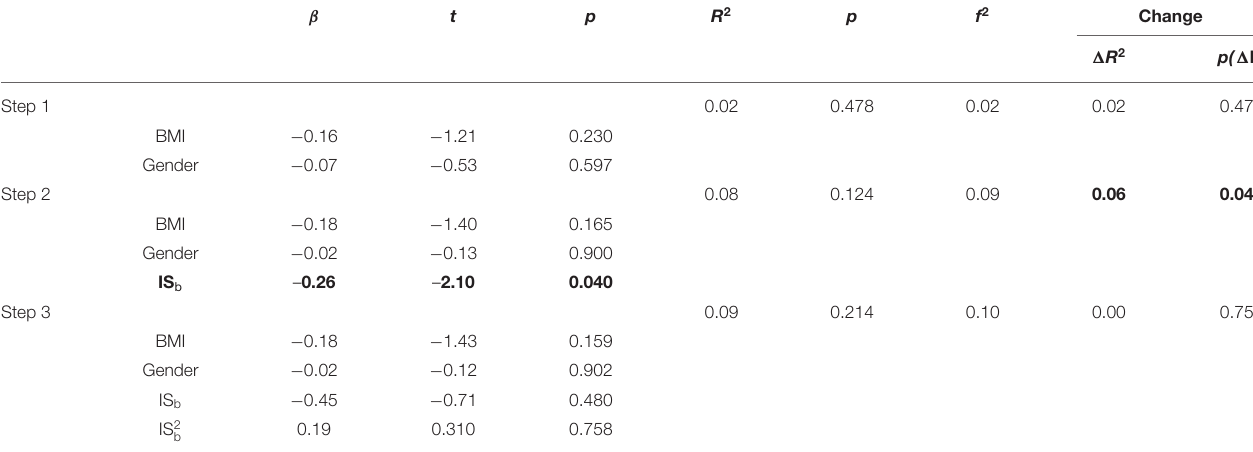
TABLE 3 | Hierarchical regression models of linear and quadratic relationships between alexithymia and baseline interoceptive sensibility.